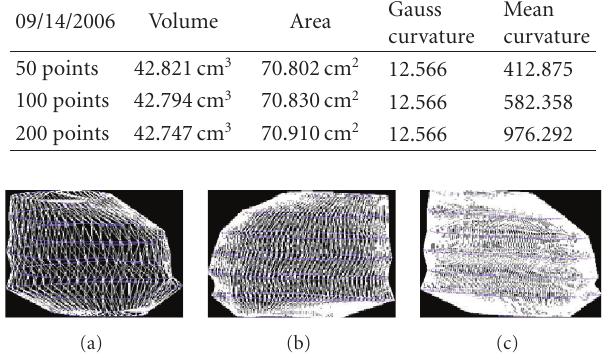
Figure 26: Patient 2. (a) 50 points on the contours, (b) 100 points on the contours, and (c) 200 points on the contours.